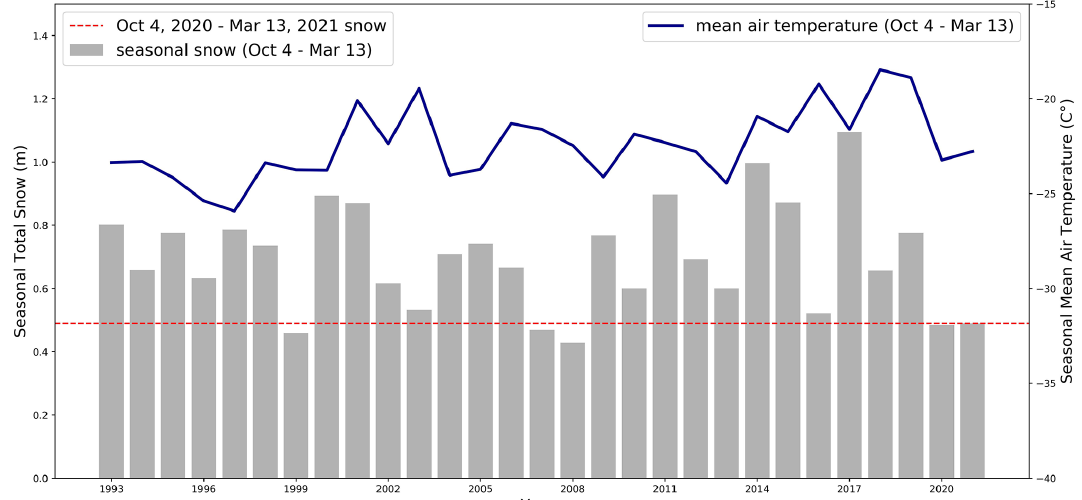
Figure 13. Total seasonal snow and mean seasonal air temperature in the OCF from 1992/1993–2020/2021 (4 October–13 March) calculated based on the daily ERA5 (global atmospheric reanalysis data, produced using the ECMWF model freely available through the Copernicus Climate Change Service). The horizontal dashed red line assists in visually comparing 2021 snow to all the other